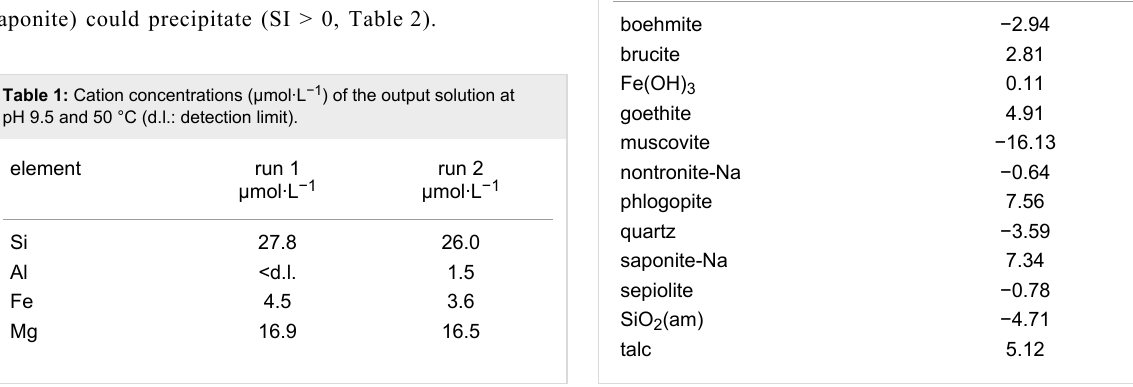
Mg concentration than that of Si (Table 1). The calculated satu- ration index (SI) values show that iron oxyhydroxide (goethite) or aluminum oxyhydroxide (boehmite), as well as some Mg-bearing aluminosilicate minerals (talc, phlogopite and saponite) could precipitate (SI > 0, Table